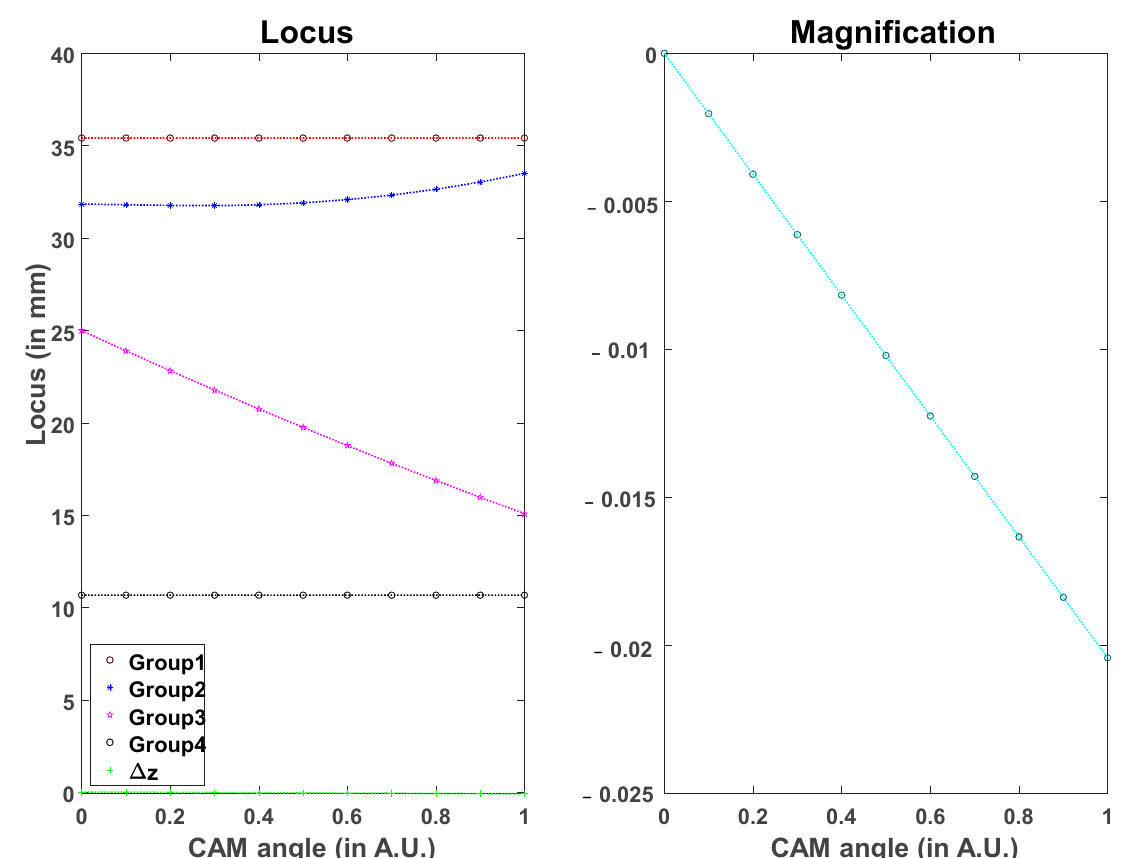
Figure 6. Locus (left) and magnification (right) for our designed final collimator system. Figure 6. Locus ( left ) and magnification ( right ) for our designed final collimator